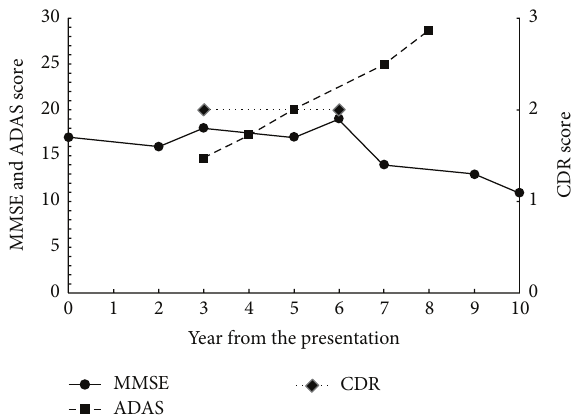
Figure 3: Changes of Mini Mental Scale Examination (MMSE), Alzheimer’s Disease Assessment Scale-cognitive subscale (ADAS), and Clinical Dementia Rating (CDR) of patient in Case A. These scores remained stable for 6 years and gradually declined during the last 4